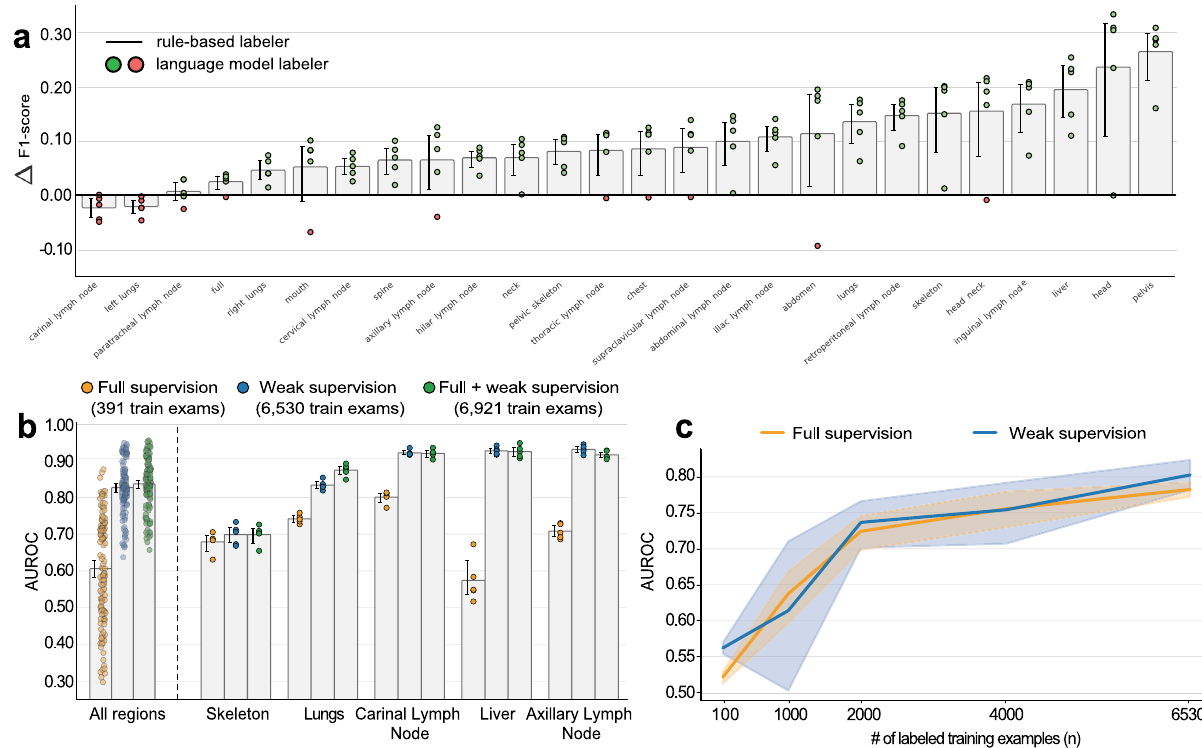
Fig. 3 Weak supervision reduces labeling costs for automated abnormality detection and location estimation. a Our labeling framework outperforms a regular expression baseline on 24 of the 26 regions speci fi ed in our test set. The fi ve dots for each region represent the difference in F1-score between the baseline and our labeling framework for fi ve different random seeds. For each region, we also show the average difference across n = 5 seeds and 95% con fi dence intervals computed via bootstrapping. b 26-region abnormality detection models trained on large data sets using weak supervision outperform models fully supervised on a small data set. We compare three models: (yellow, left) a fully supervised model trained using 391 manually annotated training examples, (blue, middle) a weakly-supervised model trained using 6530 automatically annotated training examples, and (green, right) a hybrid model trained using a combined data set of 6921 training examples, 391 of which are manually annotated. To the left, we show the distribution of AUROC across all 26 regions and 5 random seeds. Each point represents the AUROC on one region and one random seed. Bars represent mean AUROC across n = 26 regions and 5 random seeds. To the right, we compare the supervision approaches on fi ve representative regions: skeleton, lungs, carinal lymph node, liver, and axillary lymph node. Bars represent mean AUROC across n = 5 seeds and 95% con fi dence intervals computed via bootstrapping. The numbers for all regions are provided in Supplementary Table 3. c Binary abnormality detection AUROC vs. the number of training data points. The performance of our weakly-supervised model is statistically equivalent to that of a traditionally supervised baseline model (trained using summary codes) ( p = 0.1933 paired permutation test). The shape of the curve suggests that more data, which can be rapidly annotated using our framework, would lead to a continued increase in performance. The line shows the mean AUROC across n = 5 random seeds and shaded regions represent 95% con fi dence intervals computed via